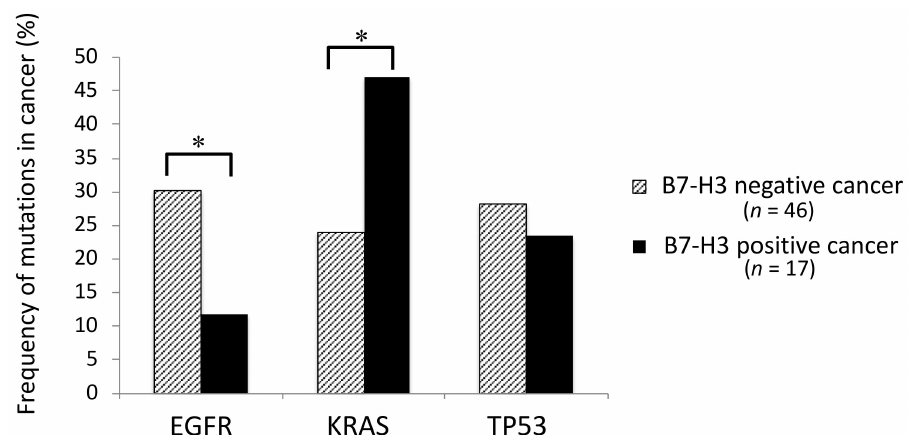
Figure 5. Frequency of EGFR , KRAS, and TP53 mutations with or without B7-H3 positivity in adenocarcinoma. There are significant differences of frequency in EGFR and KRAS mutations between B7-H3 positive and negative adenocarcinomas. *, p <